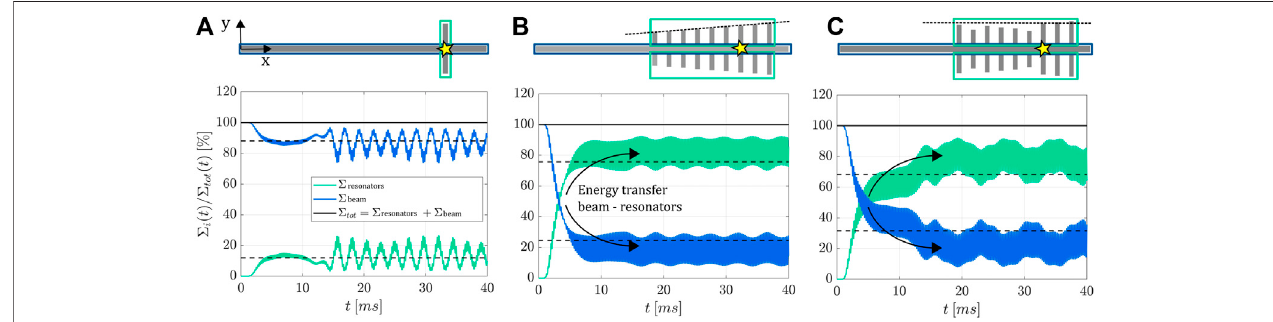
FIGURE 3 | Total energy density distributions in time for the single cell (A) , linear (B) and random array (C) . Each system is forced using a tone burst of 15 ms at 2 kHz , able to excite the fl exural resonace of the resonators in the cell marked with a yellow star. For the lone cell (A) , weak energy transfer between the beam and the resonators is achieved. Adding a linear array of resonators (B) allows to increase the ef fi ciency of energy transfer, providing strong energy con fi nement inside the resonators. A similar behaviour, but less ef fi cient, is shown for the random array (C) . To outline the differences in term of performance, the mean energy density along time is also reported with dashed black lines.